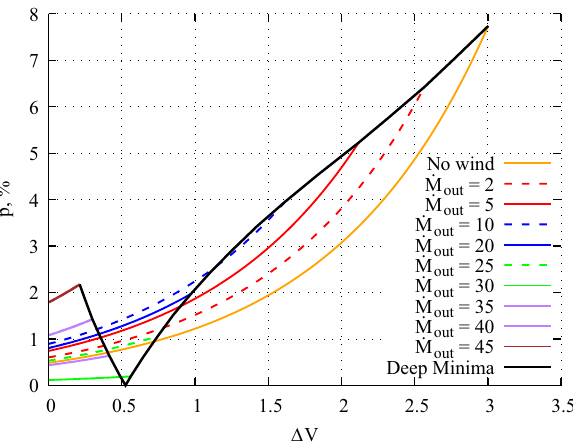
Figure 2: Dependence of the linear polarization degree on the fading level in the V band in the compact screen model for disks with di ff erent pu ffi ng - ups. The angle between the direction to the observer and the disk axis is ∘ 65 . For pu ff ed - up disks, the wind mass out fl ow rate is indicated in units of ⊙ M 10 −9 per year. No wind line matches the fl ared disk model. The Deep Minima line shows changes in the eclipse depth and the degree of polarization at the minimum brightness, depending on the mass out fl ow rate. Its break in the point with zero polarization corresponds to a change in the positional angle of linear polarization by ∘ 90